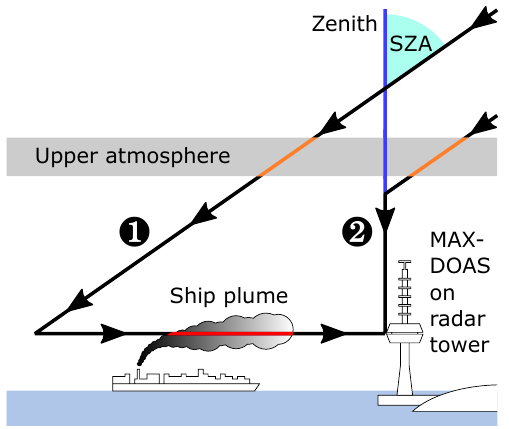
Figure 5. Measurement geometry for MAX-DOAS measurements on Neuwerk with schematic light paths for off-axis (1) and zenith sky reference measurements (2) for an exemplary solar zenith angle (SZA) of 55 ◦